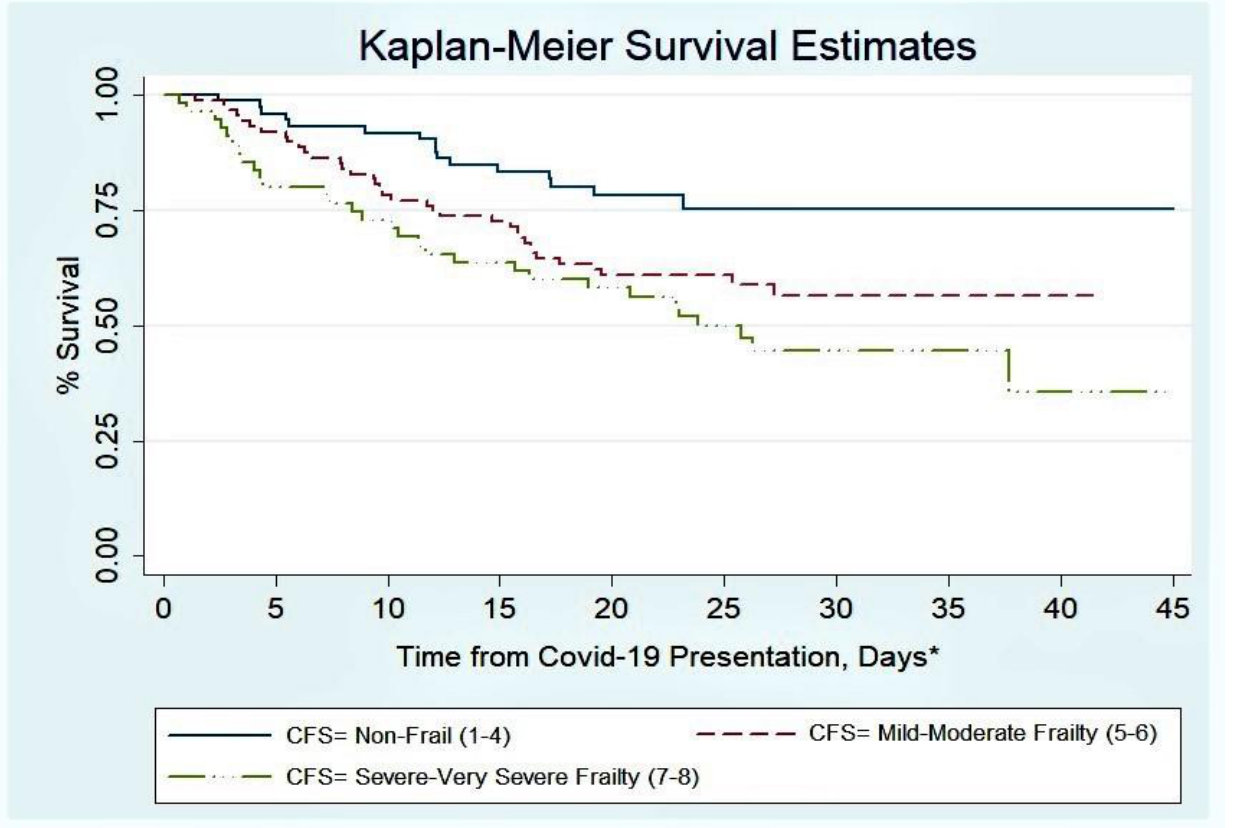
Table 3. Cox Proportional Hazards Regression Analysis: relationships between age, sex, frailty, illness acuity, multimor- bidity and death.